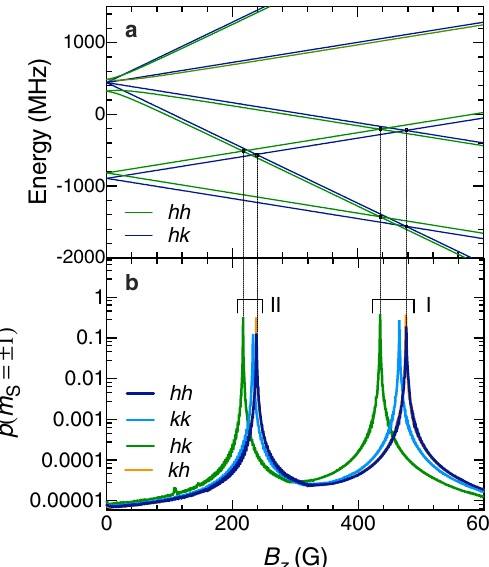
Fig. 2 Interaction with spin-1/2 defects. a Magnetic fi eld depen- dence of the energy levels of hh (dark blue) and hk (green) divacancies coupled to a single spin-1/2 point defect. b Population of the m S = ±1 spin states of the hh (dark blue), kk (light blue), hk (green), and kh (amber) divacancies induced by a bath of spin-1/2 environmental defects at the concentration of 10 18 cm − 3 . The depicted curves show the magnetic fi eld dependence of the population enhancement of the m S = ±1 states of the divacancies. Each curve exhibits two resonances corresponding to B GSLAC D ; E ð Þ (group I) and B GSLAC D ; E ð Þ = 2 (group II), where D and E are the ZFS parameters of the corresponding divacancy defect. In a and b the magnetic fi eld is parallel to the quantization axis of the divacancy qubits in all cases. At t = 0, the central divacancy is initialized in the m S = 0 state, while the spin bath is in a high-temperature thermal state.